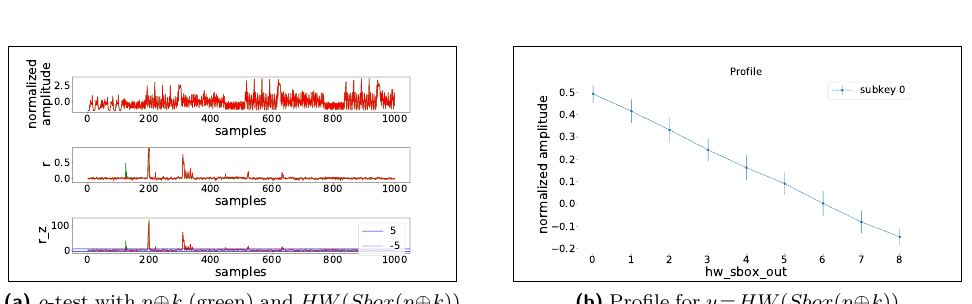
Figure 5: In the conventional case the Hamming Weight model is a good assumption. Results of the ρ -test for the first byte of the key (a). Assuming the HW [ Sbox [ p ⊕ k ]] leak model (red) does not significantly reduce correlation for the highest POI, compared to choosing p ⊕ k (green). The profile (b) clearly shows almost linear negative correlation.